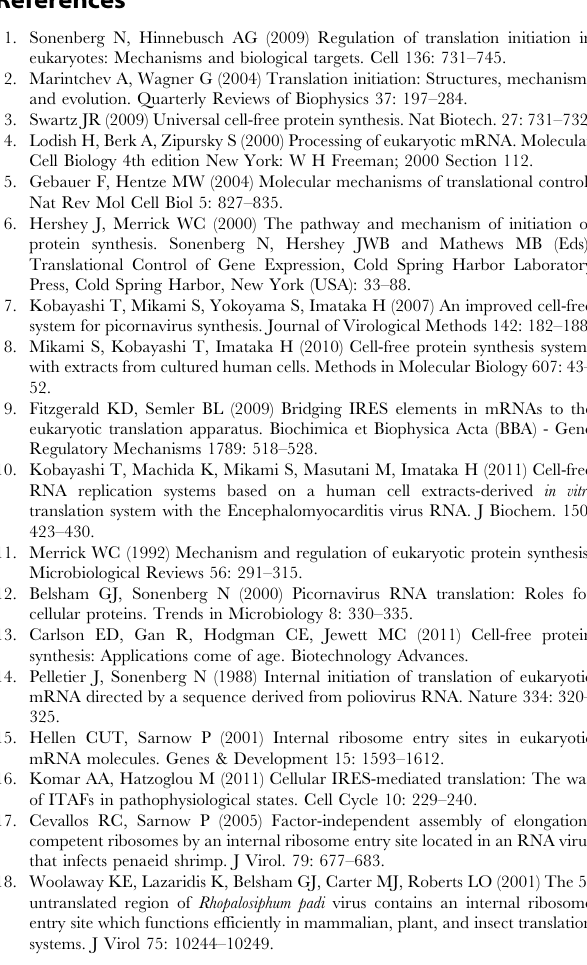
Figure S1 IRES sequences used in this study. Figure S2 Scheme of the expression constructs used in this study. Figure S3 Workflow of the cell-free protein synthesis reactions using eukaryotic cell extracts.